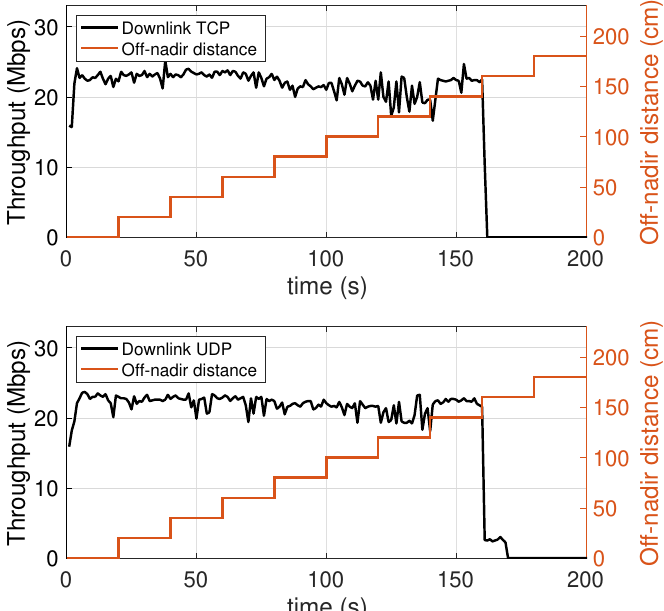
Figure 12. Downlink throughput with varying off-nadir distance of the mobile device. TCP (top chart) and UDP (bottom